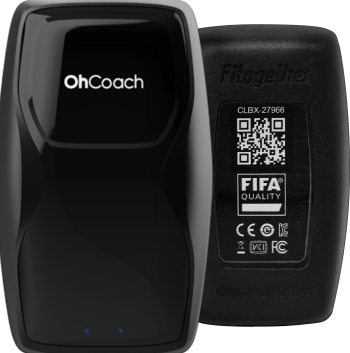
Figure 1. A wearable EPTS of football